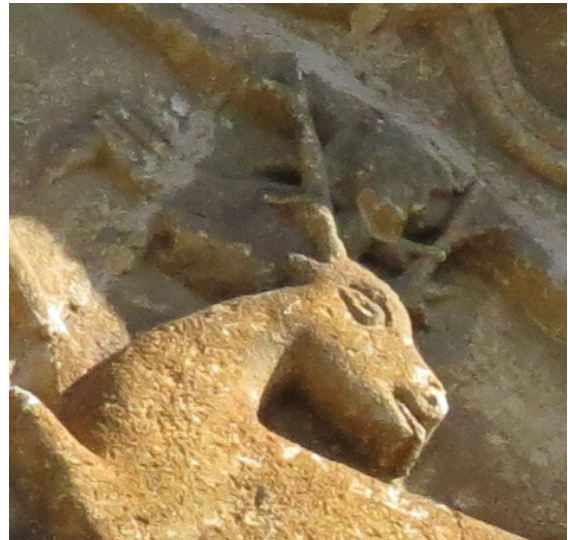
Figure 27. Christ between the stag’s antlers, Saint Eustace and the stag, detail of archivolt,